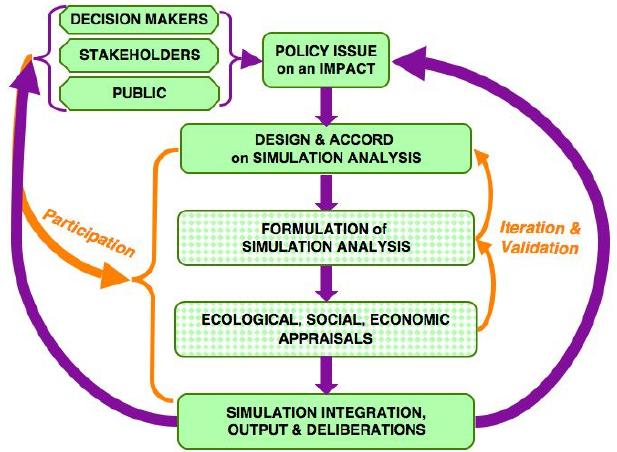
Fig. 5 . Schematic of the SAF implementation for an ICZM Policy Issue.